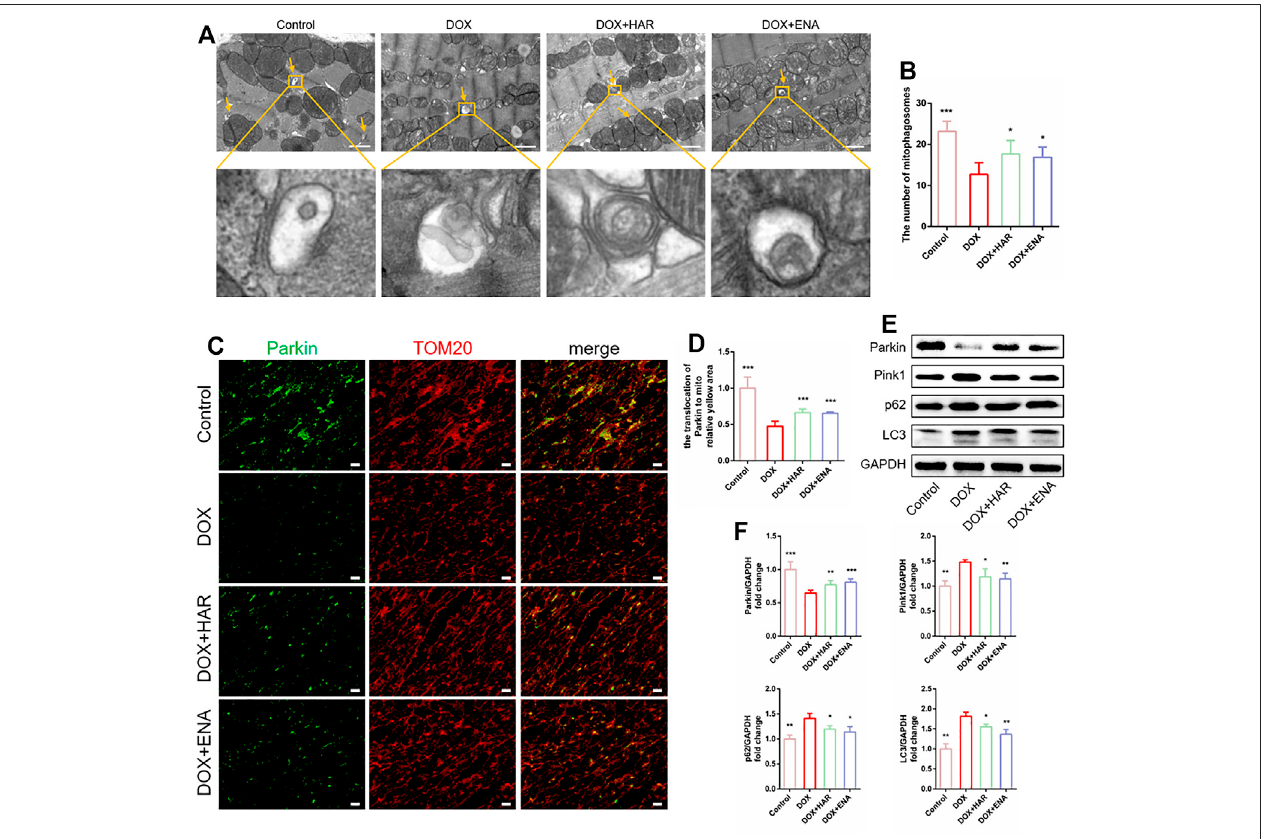
FIGURE 3 | HAR enhanced Parkin-mediated mitophagy in DICT mice. (A,B) Representative electron micrographs of the heart and the quanti fi cation of mitophagosomes. Scale bar: 1 μ m. Magni fi ed image represents an mitophagosomes. The number of mitophagosomes was quanti fi ed blindly using 10 images from 6 samples. (C,D) Representative images of colocalization of Parkin and TOM20. Scale bar: 20 μ m. (E,F) Expression levels of p53-dependent mitophagy-associated proteins quanti fi ed and shown as relative protein expression levels after normalization to GAPDH. * p < 0.05, ** p < 0.01, *** p < 0.001 vs. DOX group ( n = 3 – 6). The data are shown as the mean ±